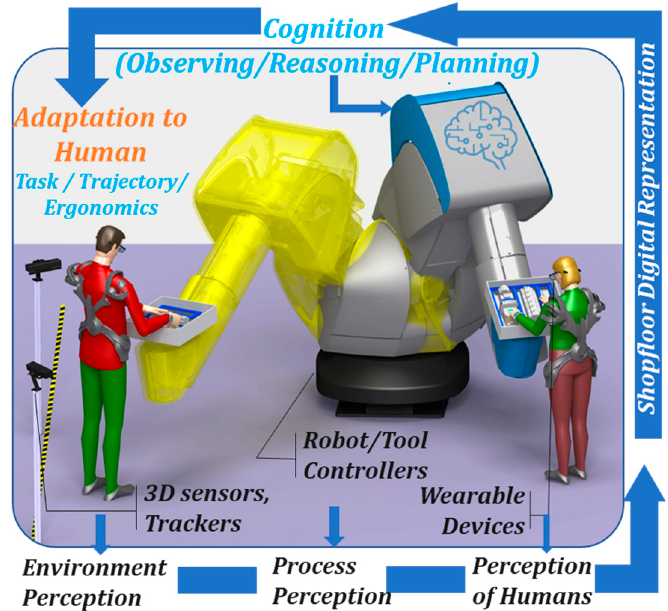
Figure 1. Constituting elements and functions of an HRC system.